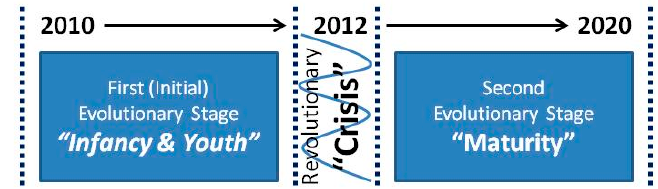
Figure 2. Trek’s Evolution over time (2010–2020).